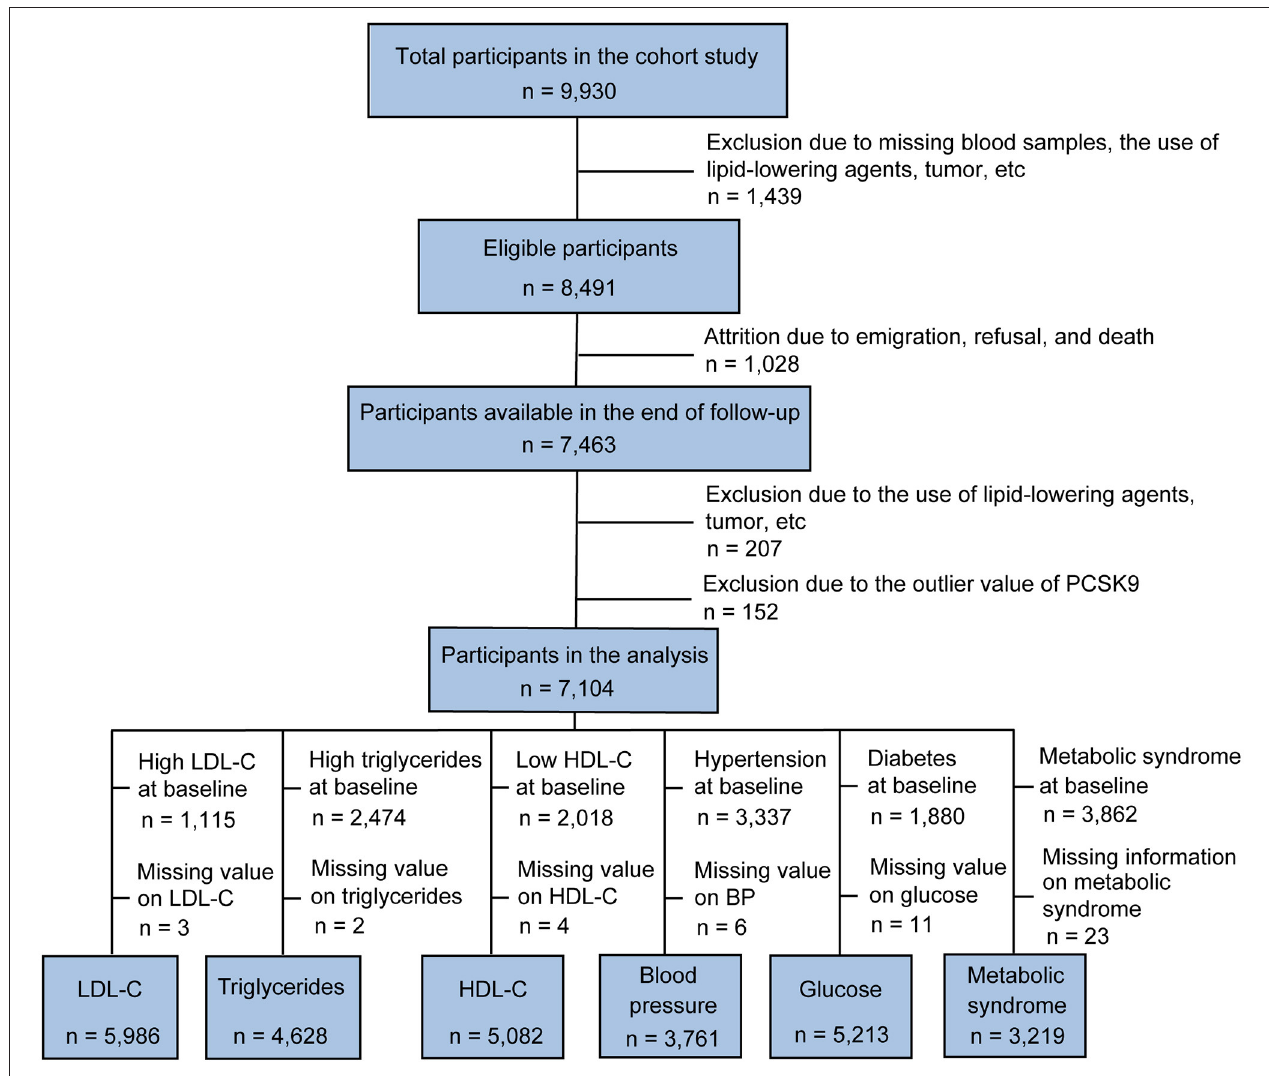
FIGURE 1 | Overview of the study